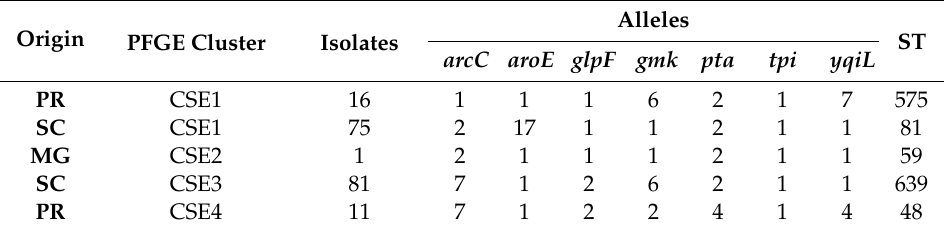
Table 5. Identification of the sequence type (ST) of Staphylococcus epidermidis isolates.